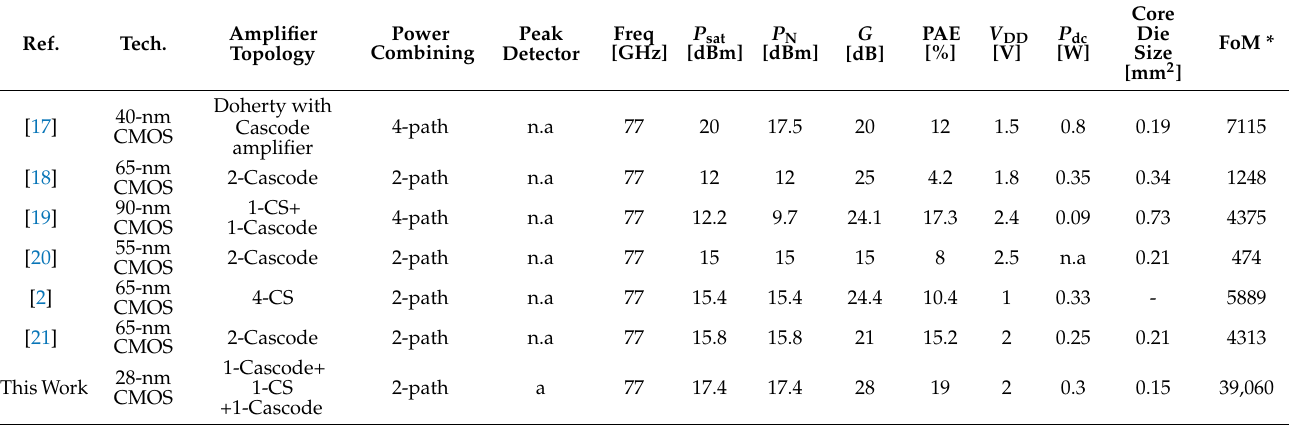
Table 1. Performance comparison with the state-of-the art 77 GHz